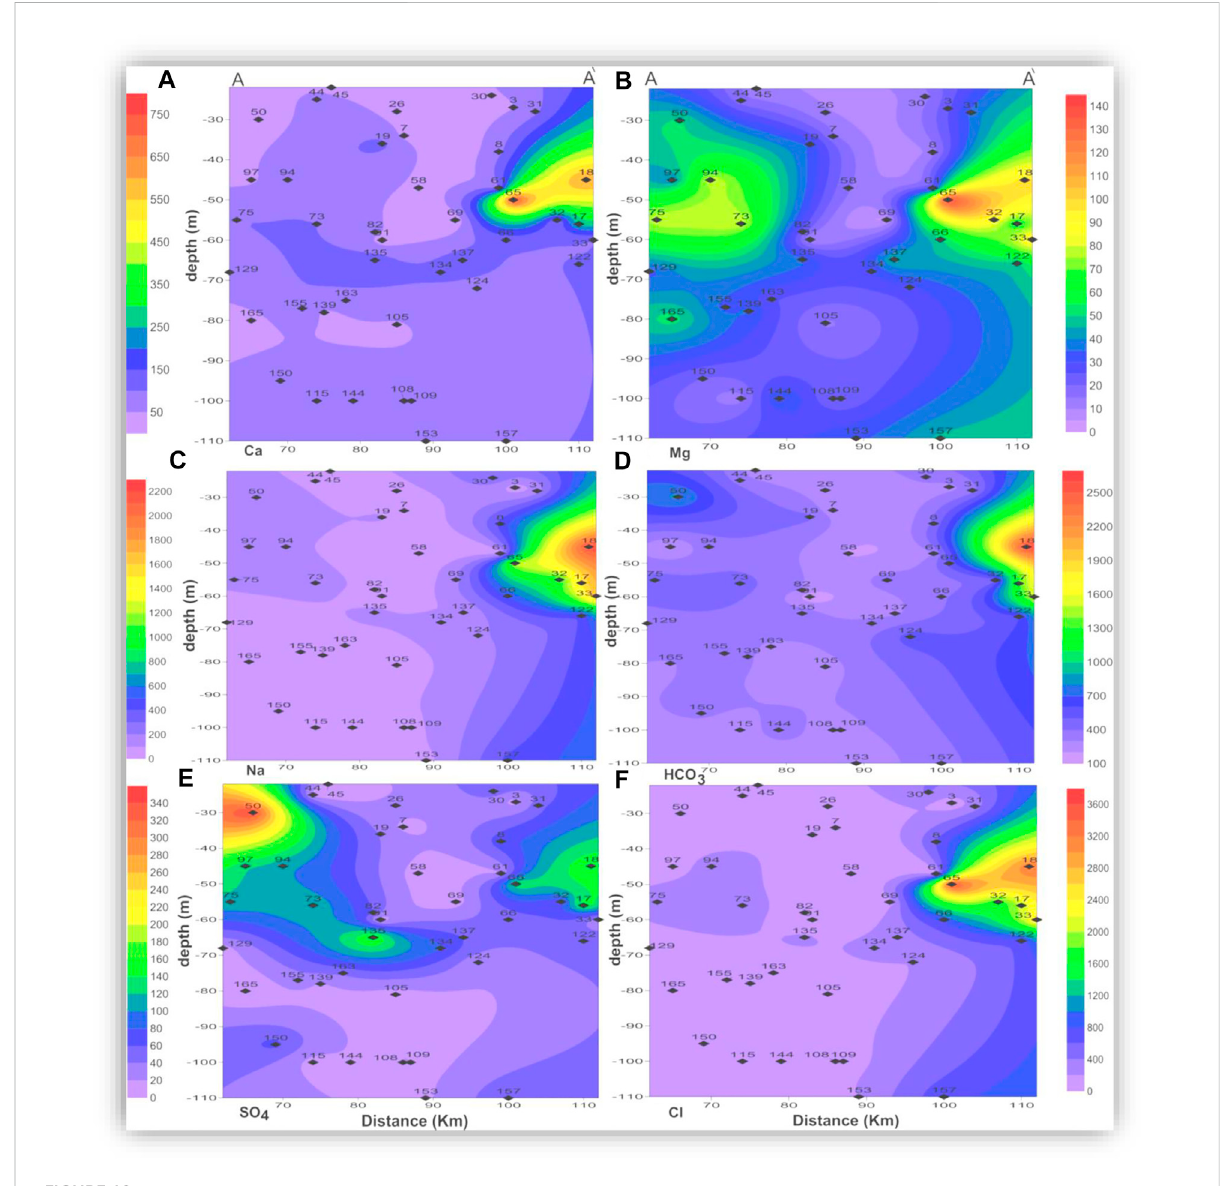
FIGURE 10 Vertical distribution of the major ion concentrations (mg/l) along the cross-section AA ’